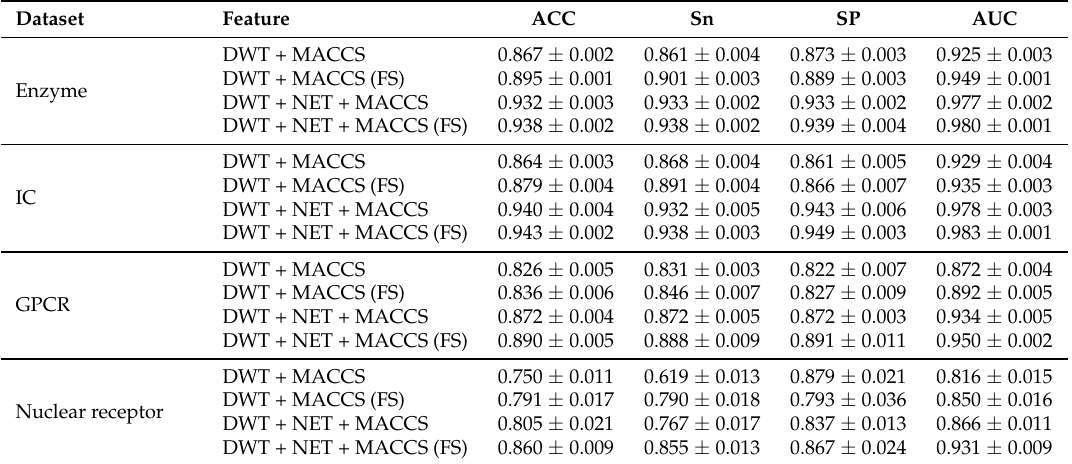
Table 2. Comparison of the prediction performance between different features on balanced datasets.